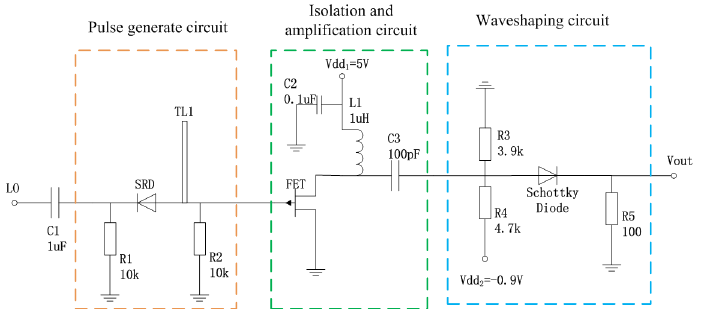
Fig 6. Circuit of the picosecond pulse